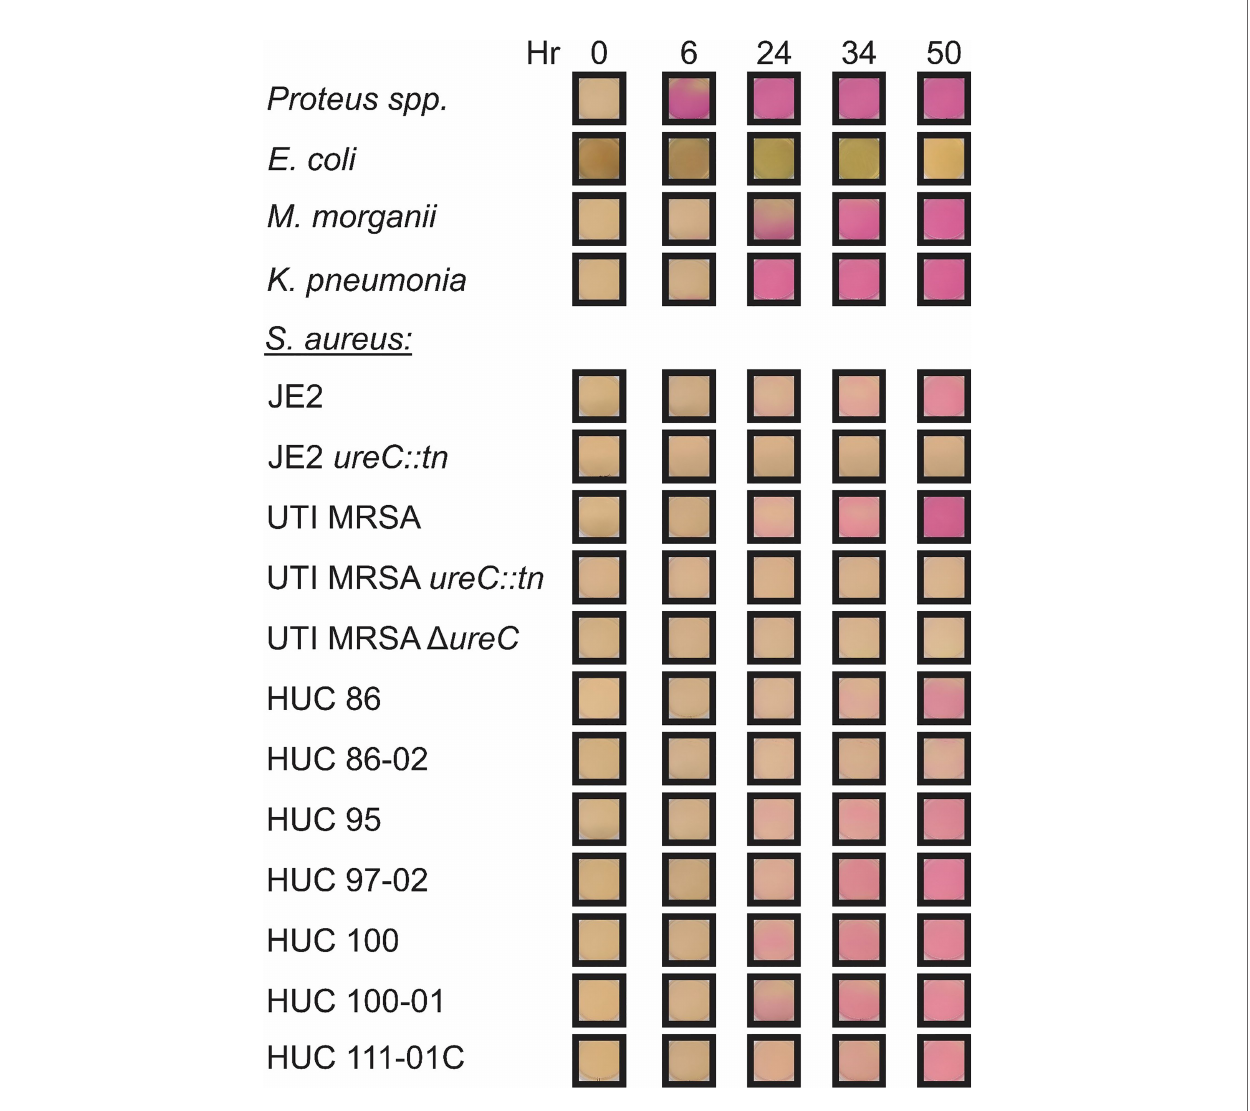
FIGURE 3 | Representative assay of the Christensen Urea Agar urease activity test. Christensen Urea Agar plates were streaked with a single colony of each bacterial strain: Proteus spp. , Escherichia coli, Klebsiella pneumonia, Morganella morganii , and Staphylococcus aureus strains including JE2, JE2 ureC::tn , UTI MRSA, UTI